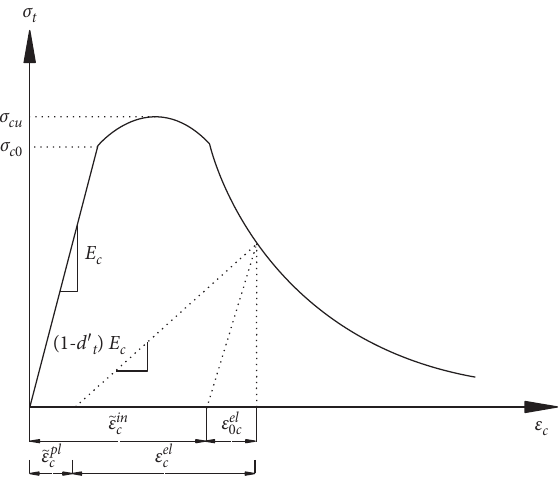
Figure 7: Definition of the cracking stain of concrete.